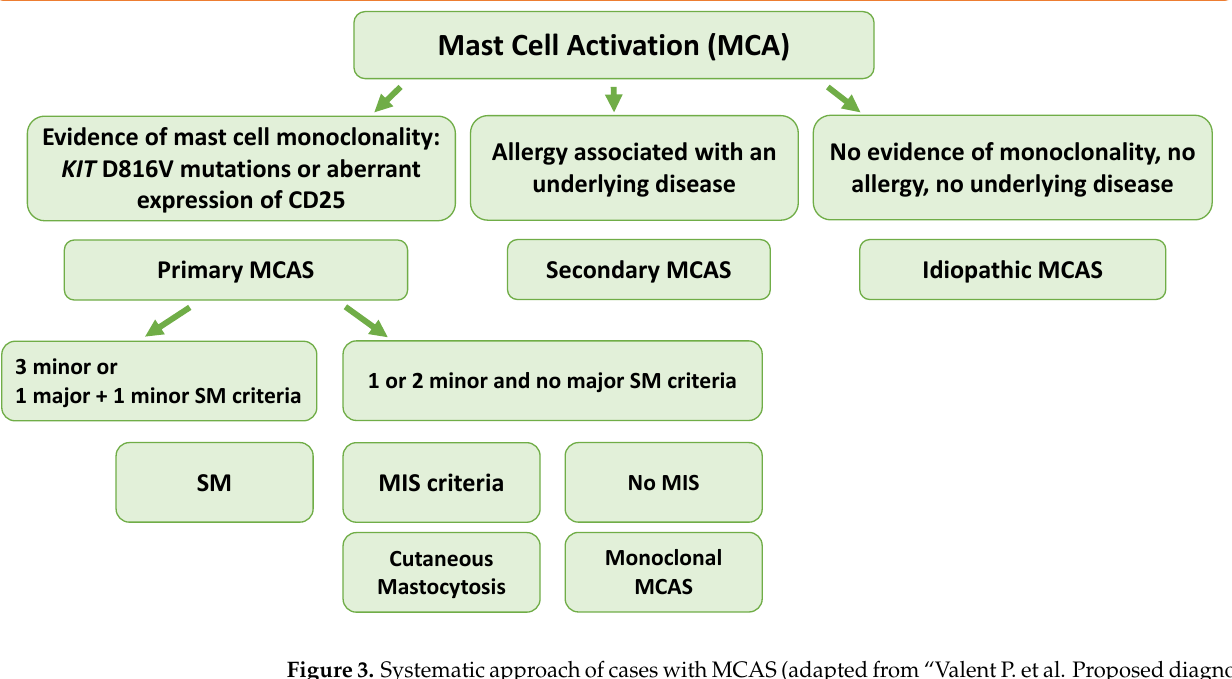
Figure 3. Systematic approach of cases with MCAS (adapted from “Valent P. et al. Proposed diagnostic algorithm for patients with suspected Mast Cell Activation Syndrome. J Allergy Clin Immunol Pract